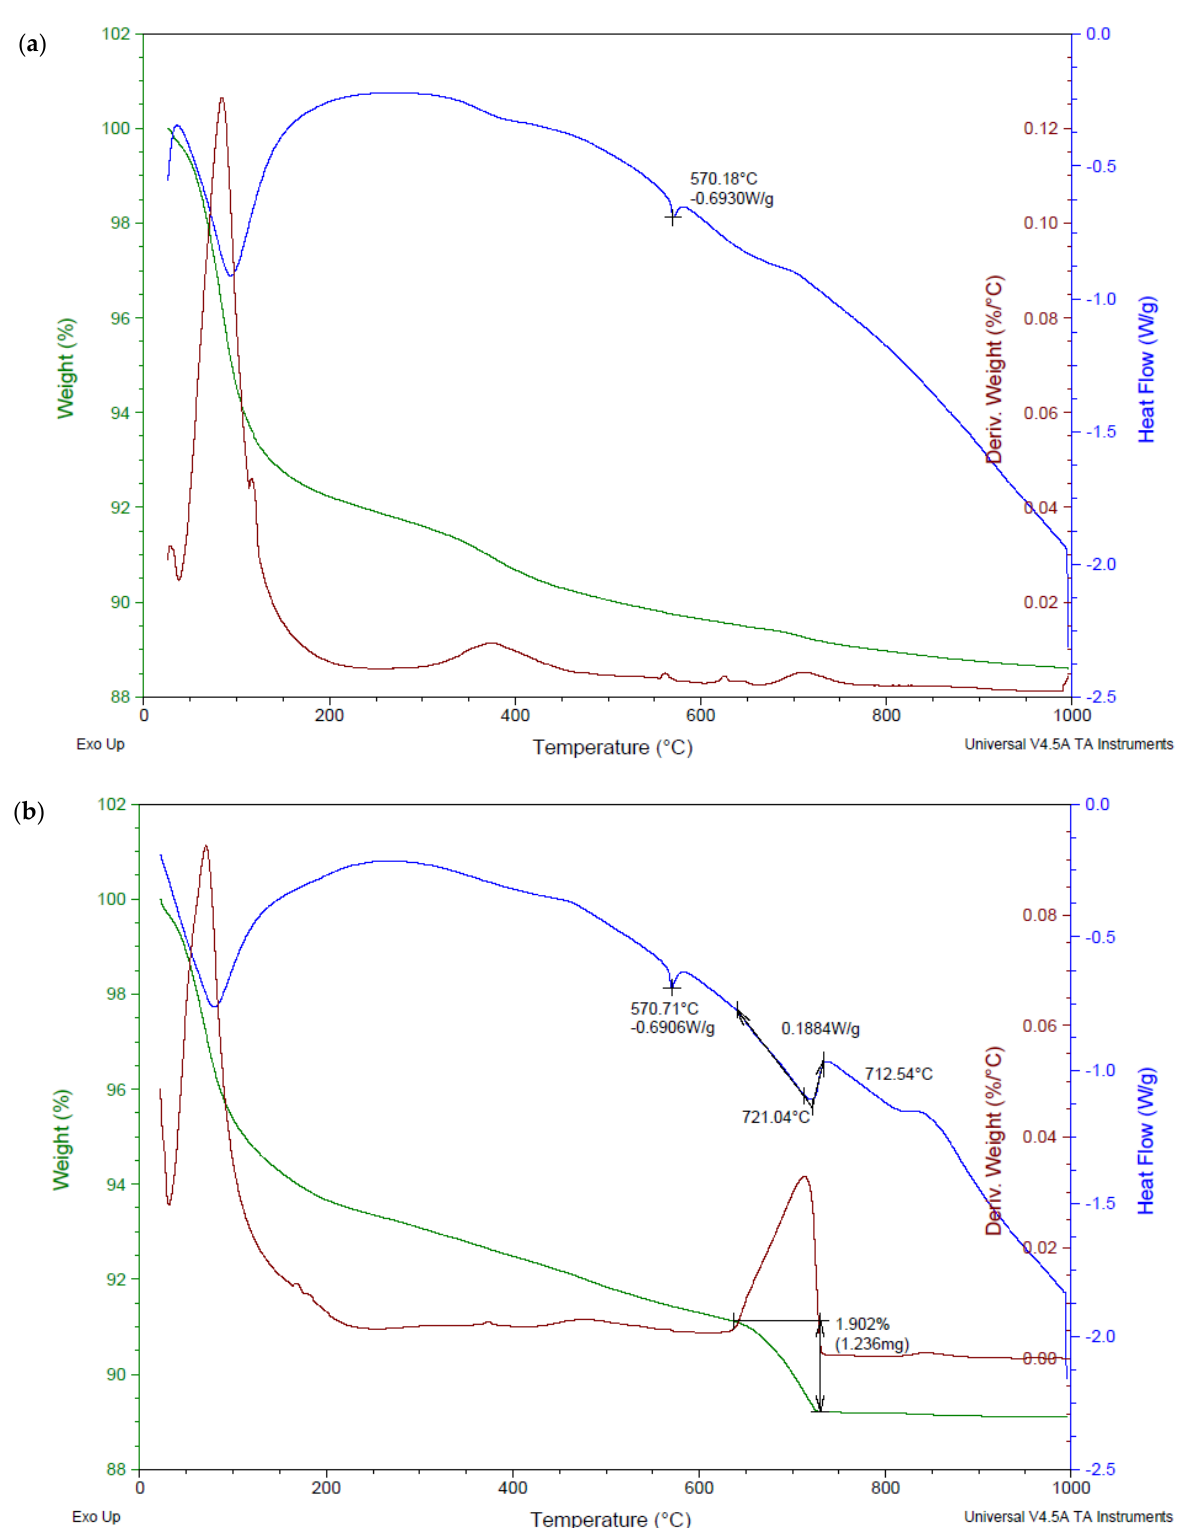
Figure 8. Thermal analysis REC 1 ( a ) indoor storage ( b ) in situ storage.